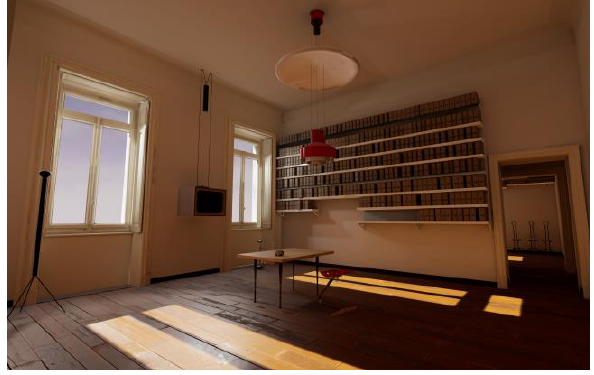
Figure 8. Virtual simulation: view of the Drafting Machines Room set up as the living room of Villa